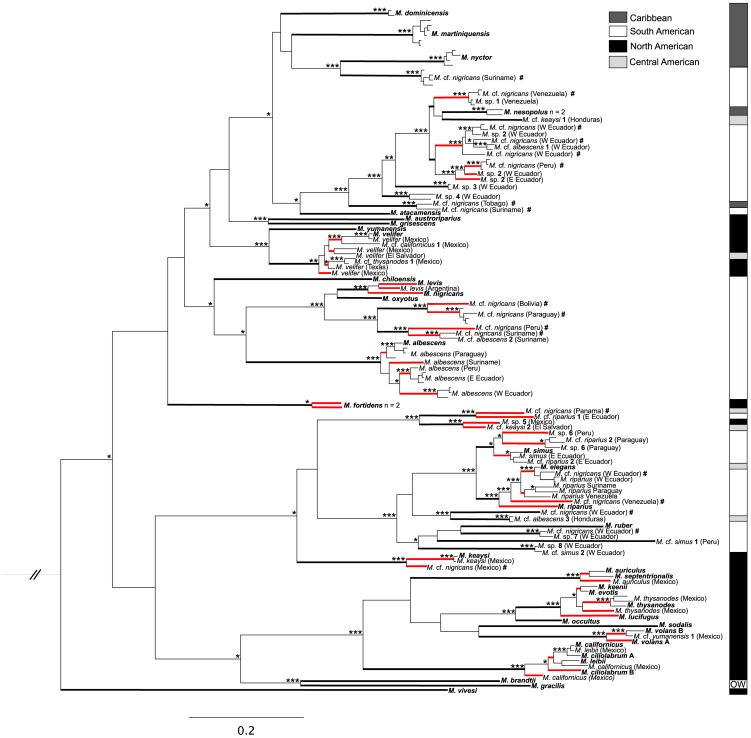
Bayesian phylogram of cytochrome-b sequence data (n = 140).Species names are based on museum and field records. Bolded species names are currently recognized by Simmons [13] and serve as the species representative (from GenBank [2], [3], [16] or from specimens sequenced herein). Black bolded branches are lineages that are ≥5.0% divergent and red bolded branches are lineages ≥2.0% divergent. Bolded numbers within species names indicate specimens that were originally identified as the named species, but were found to be independent lineages that are ≥5.0% divergent. The pound sign (#) indicates all specimens originally identified as M. nigricans. OW = Old World lineages of M. brandtii and M. gracilis. Kerivoula papillosa and M. latirostris are outgroup taxa but are not shown in the phylogram. Support for nodes are presented as Bayesian posterior probabilities ≥0.95 (*), maximum likelihood bootstrap pseudo-replicate values ≥75% (**), or support in both analyses (***). Additional specimen information is in Table S1.